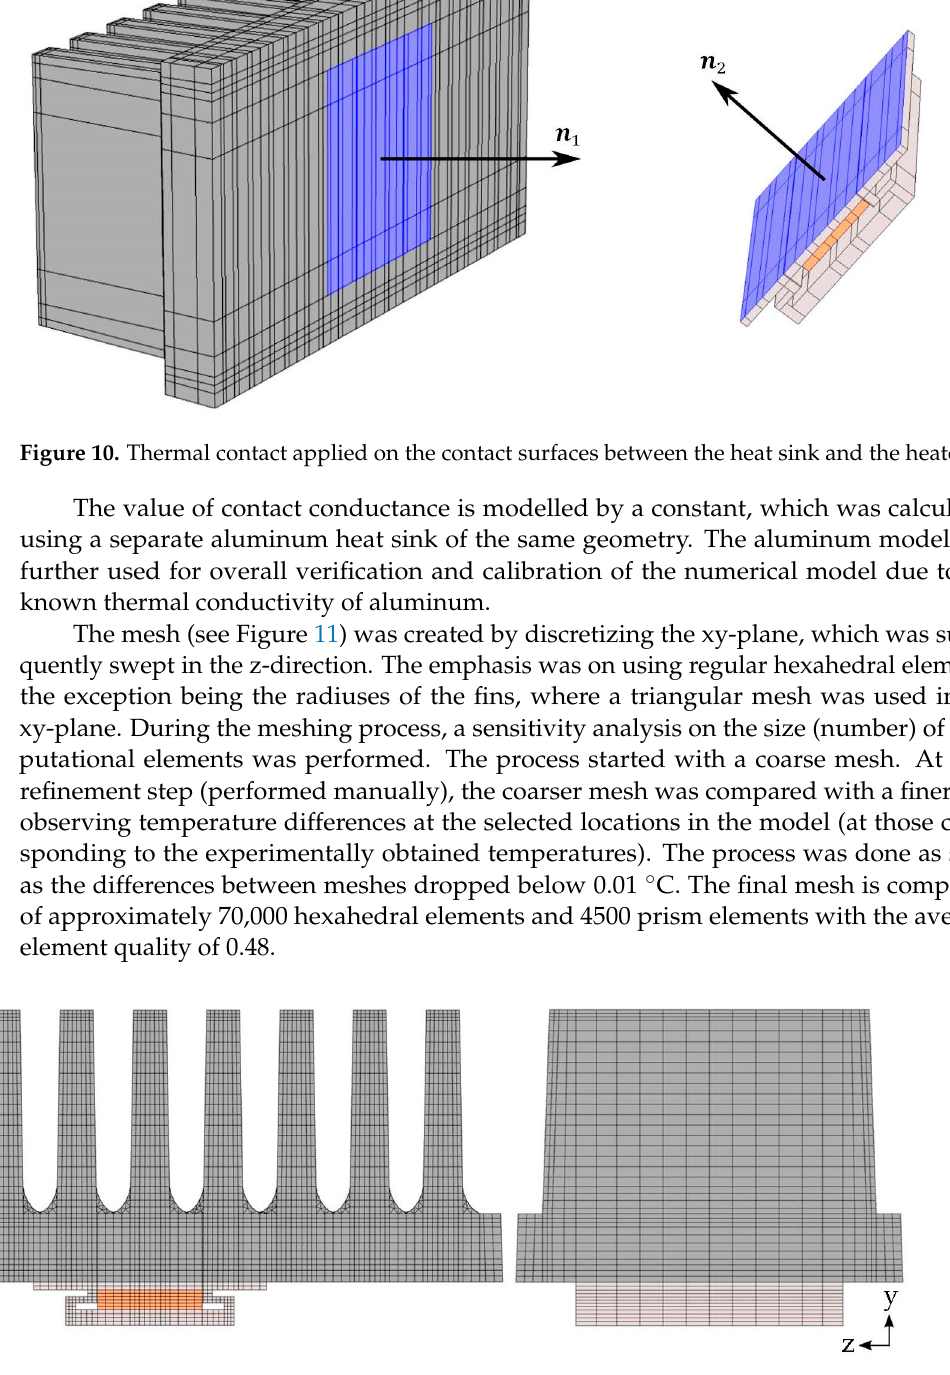
Figure 11. The mesh of the numerical model, view on the xy-plane ( left ) and on the yz-plane ( right ). All input parameters to the numerical model except thermal conductivity of the composite are summarized in Table Table 1. Input parameters of the numerical model.